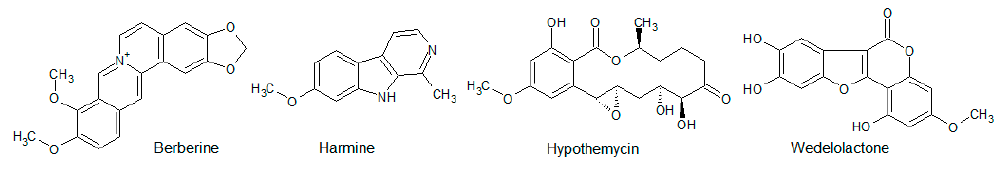
Figure 12. Chemical structures of other natural protein kinase inhibitors.